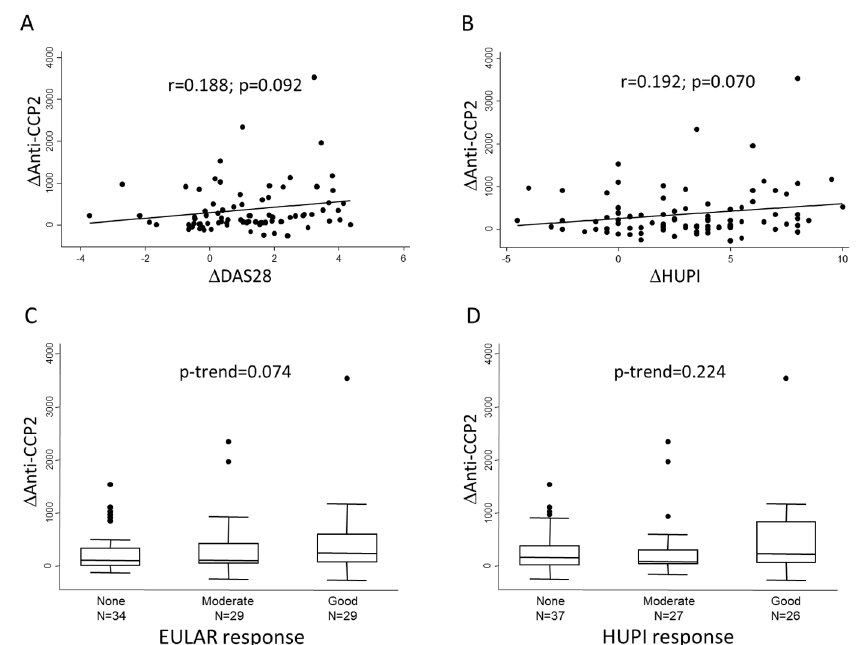
Figure 2. Association between change in anti-CCP2 levels and therapeutic response at six months of follow-up. Panels ( A , B ) show the lineal correlation between change in anti-CCP2 levels ( ∆ anti CCP-2) and change in disease activity assessed either with DAS28 or HUPI scores, respectively. Panels ( C , D ) show Δ anti-CCP2 distribution according to categories of response; in this panels dots represent outliers. Statistical significance was assessed through Spearman’s correlation test in panels ( A , B ) and with Cuzick’s test in panels ( C , D ).